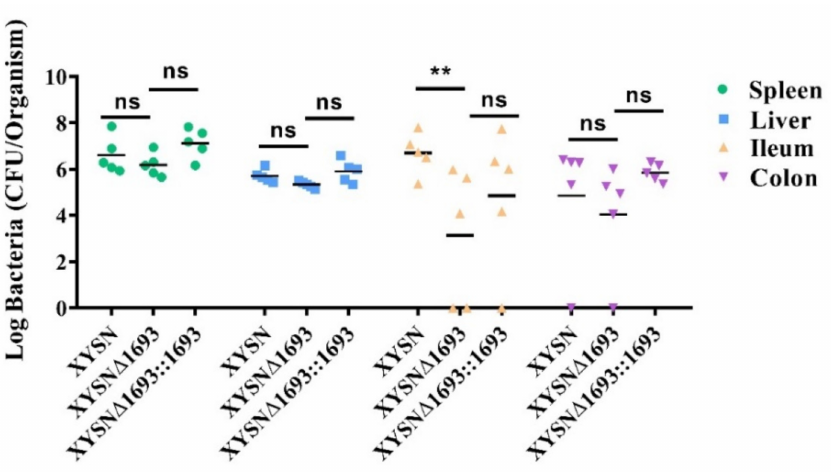
Figure 6. Bacteria loads in organs after Lm infection mice. Lm XYSN, XYSN ∆ 1693 and XYSN ∆ 1693 :: 1693 (3 × 10 6 CFU) were intragastrically inoculated to mice (n = 5). Animals were euthanized 72 h after infection, and organs were recovered, homogenized and plated. The numbers of bacteria able to colonize the ileum, colon, liver and spleen are shown. Among them, spleen is represented by the green circle, liver is represented by the blue square, ileum is represented by the orange triangle and colon is represented by the purple reverse triangle. Values are mean ± SEM; n = 3 independent experiments. Statistical analysis was performed using Tukey’s multiple